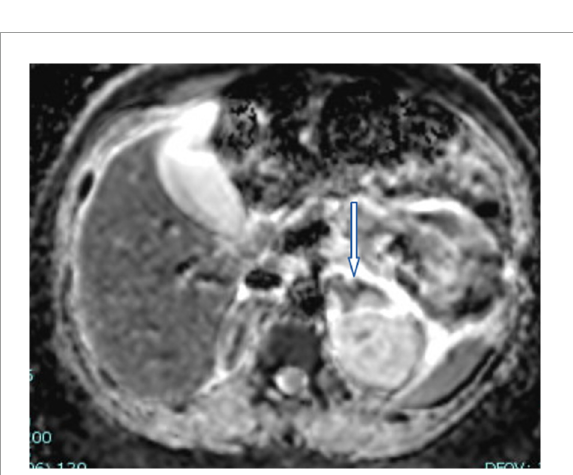
FIGURE3 A representative image of adrenal glands with magnetic resonance imaging. The marked hypointensity signal confirmed the presence of adrenal hemorrhage.